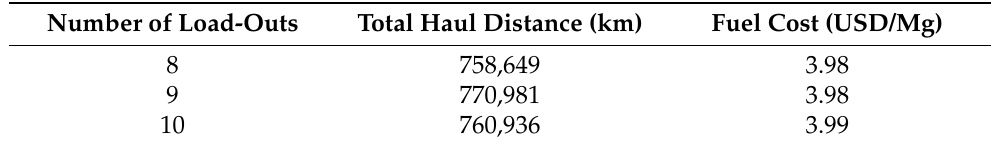
Table 7. Haul distance and fuel cost (USD/Mg annual delivery) for the three load-out